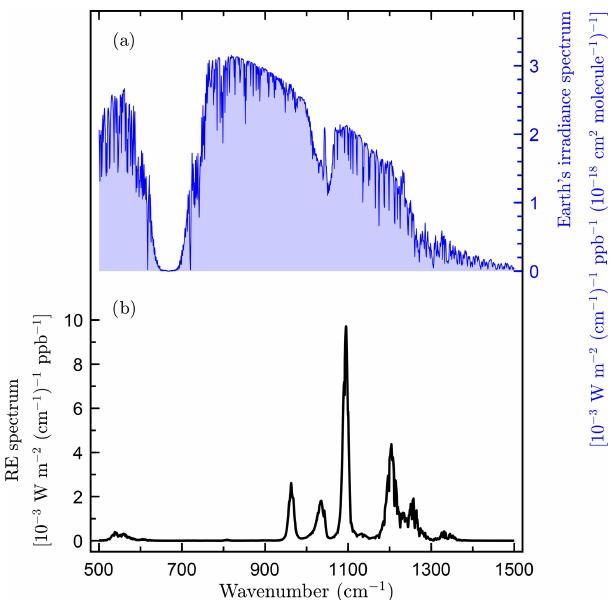
Figure 4. (a) Earth’s irradiance spectrum as reported by Hodnebrog et al. (2013) and (b) radiative efficiency (RE) spectrum of octafluo- rooxolane ( c -C 4 F 8